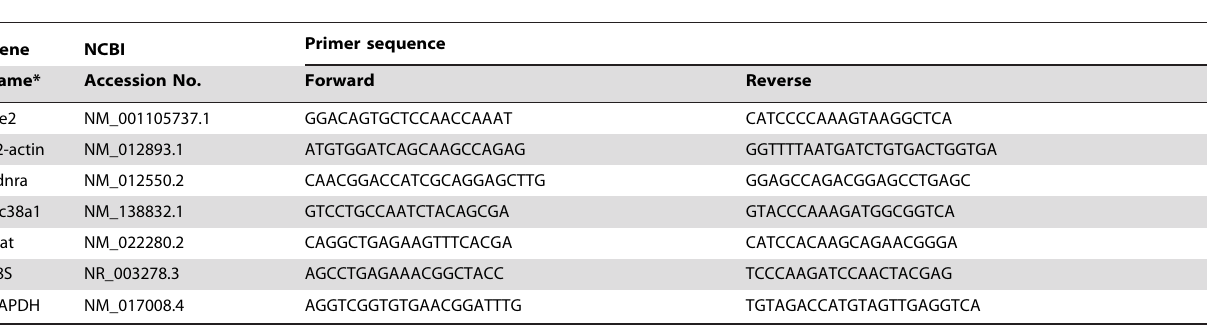
Table 1. List of primer sequences used for quantitative